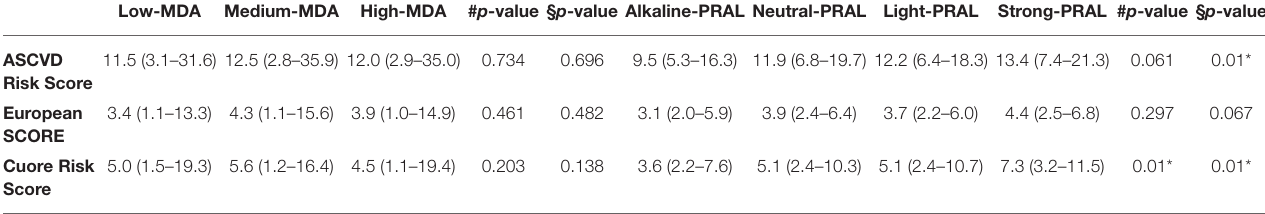
TABLE 5 | Cardiovascular risk scores per MDA score tertile and PRAL